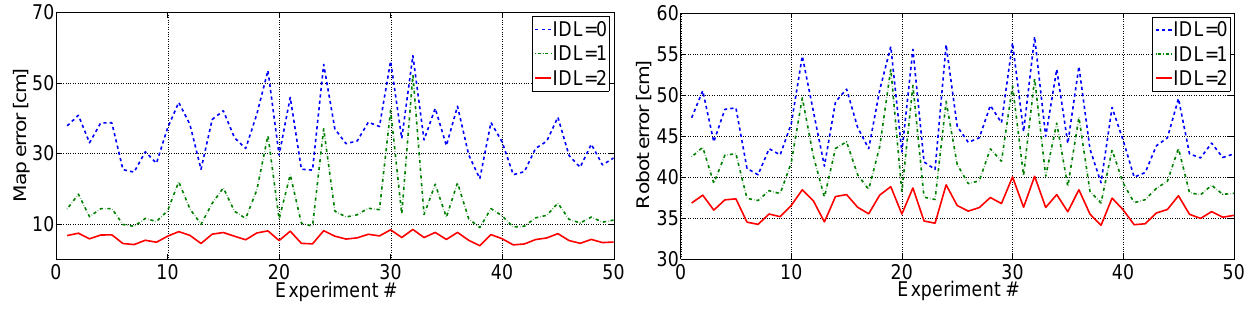
Figure 6. Mean beacon location errors ( left ) and mean robot location errors ( right ) in 50 experiments with IDL = 0, IDL = 1 and IDL =